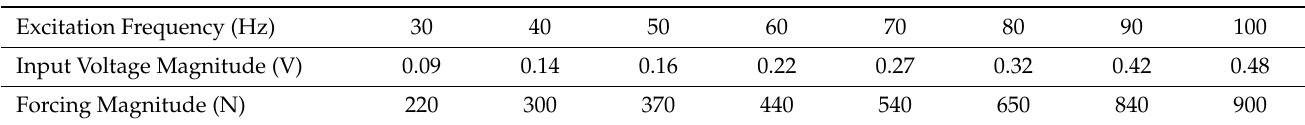
Table 1. Input excitation frequencies and their corresponding input voltage magnitudes and forcing